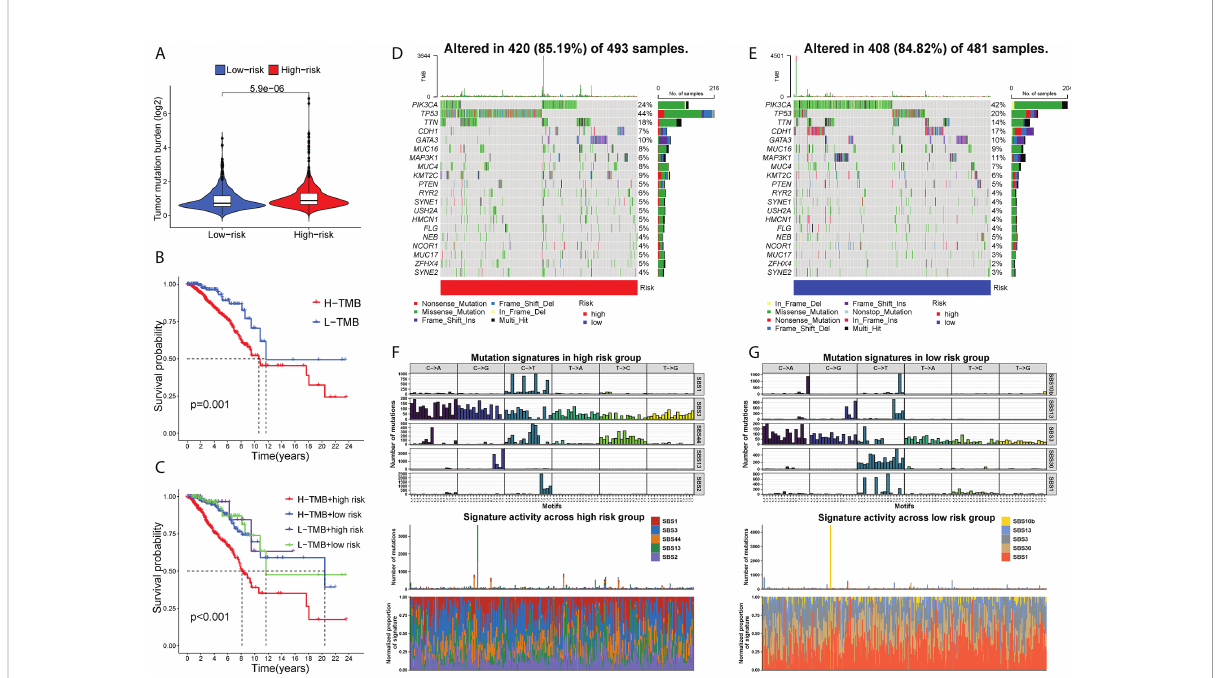
FIGURE 8 TMB and mutational pro fi les. (A) The estimated TMB score between two risk groups. The Kaplan-Meier curves showing the OS of BC patients under different TMB scores (B) and under different combinations of the risk score with TMB scores (C) . The mutational landscape of high- (D) and low-risk (E) patients. (F, G) The mutation signatures in two risk